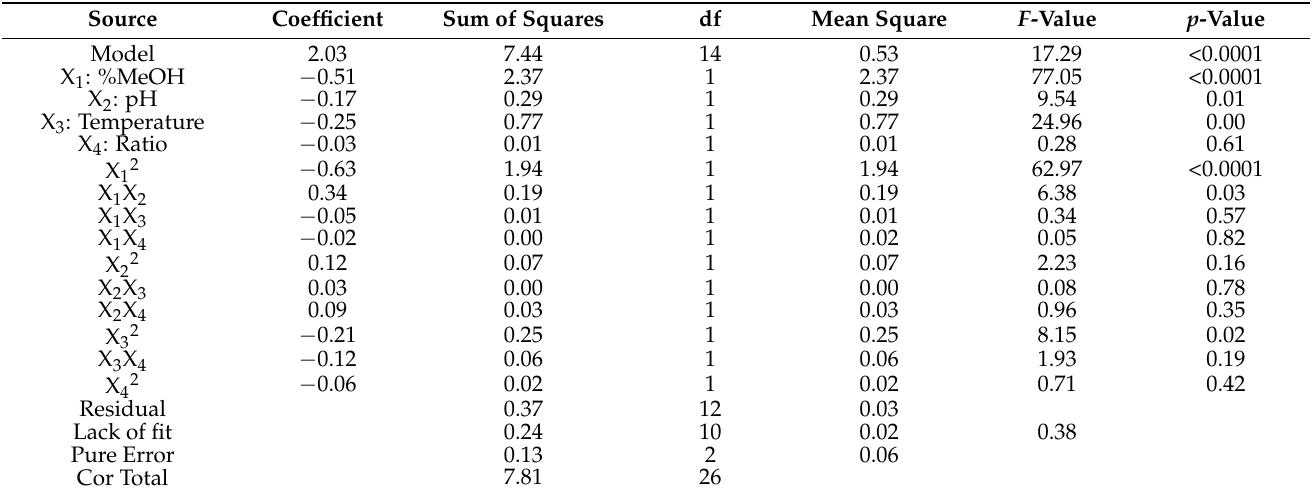
Table 2. ANOVA of the total anthocyanins in the MAE extracts.